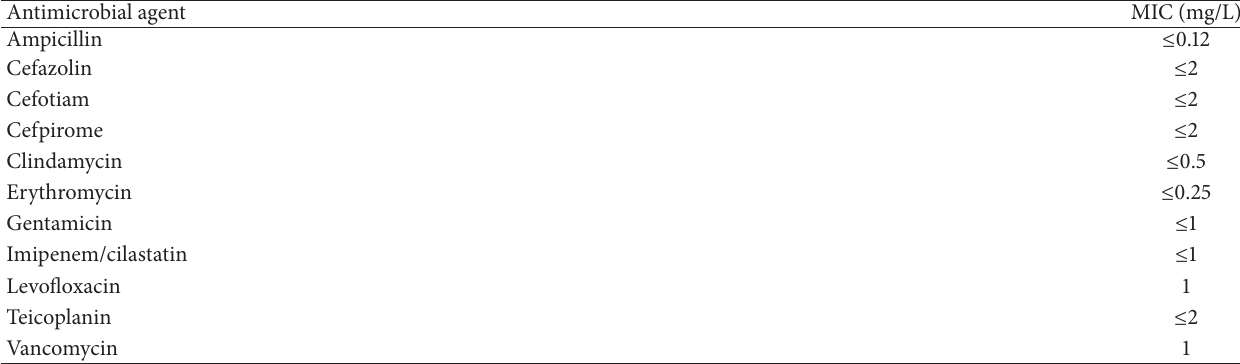
Table 1: The results of antimicrobial susceptibility testing.